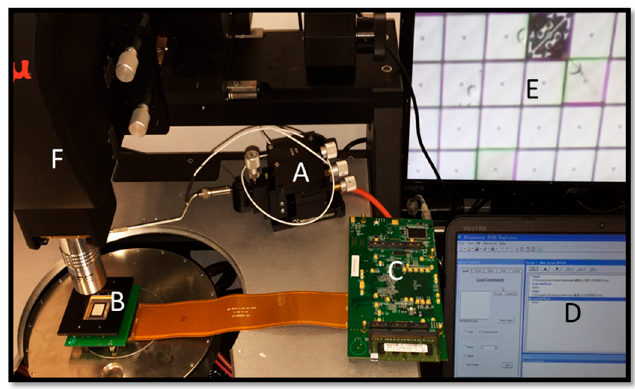
Figure 2. Experimental setup under an optical microscope: The micromanipulator ( A ) was used to bond nanowire onto the micromirrors of DMD chip ( B ), which connected with the digital light processing (DLP) circuit board ( C ) via data cable. In order to control the individual DMD pixel (micromirror), the customized programming software ( D ) will transmit the binary signal to ( C ). During the testing, the real time images ( E ) will be captured by a high magnification optical microscope ( F ) equipped with a high-speed camera.